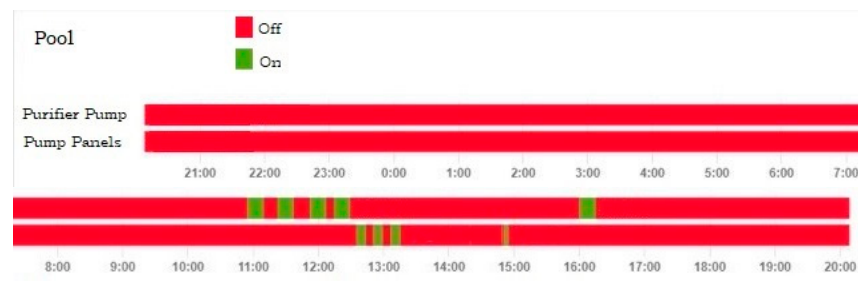
Figure 7. Evolution of water pool and solar collector temperature in scenario 3.